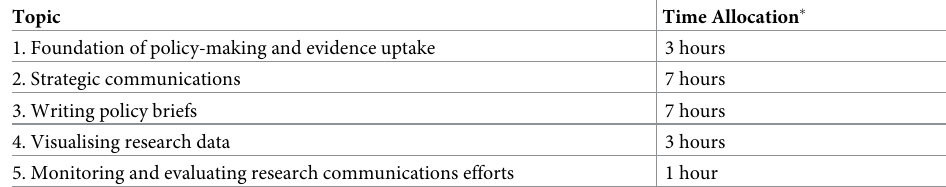
Table 3. Training topics and allocated